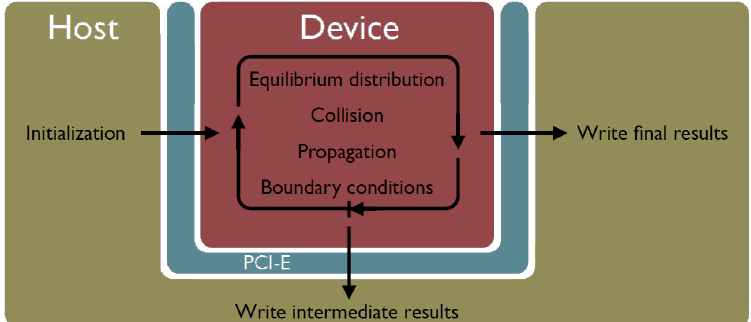
Figure 1. Typical bottlenecks of GPU-accelerated simulations: data transfer from host to device and vice versa during initialization and